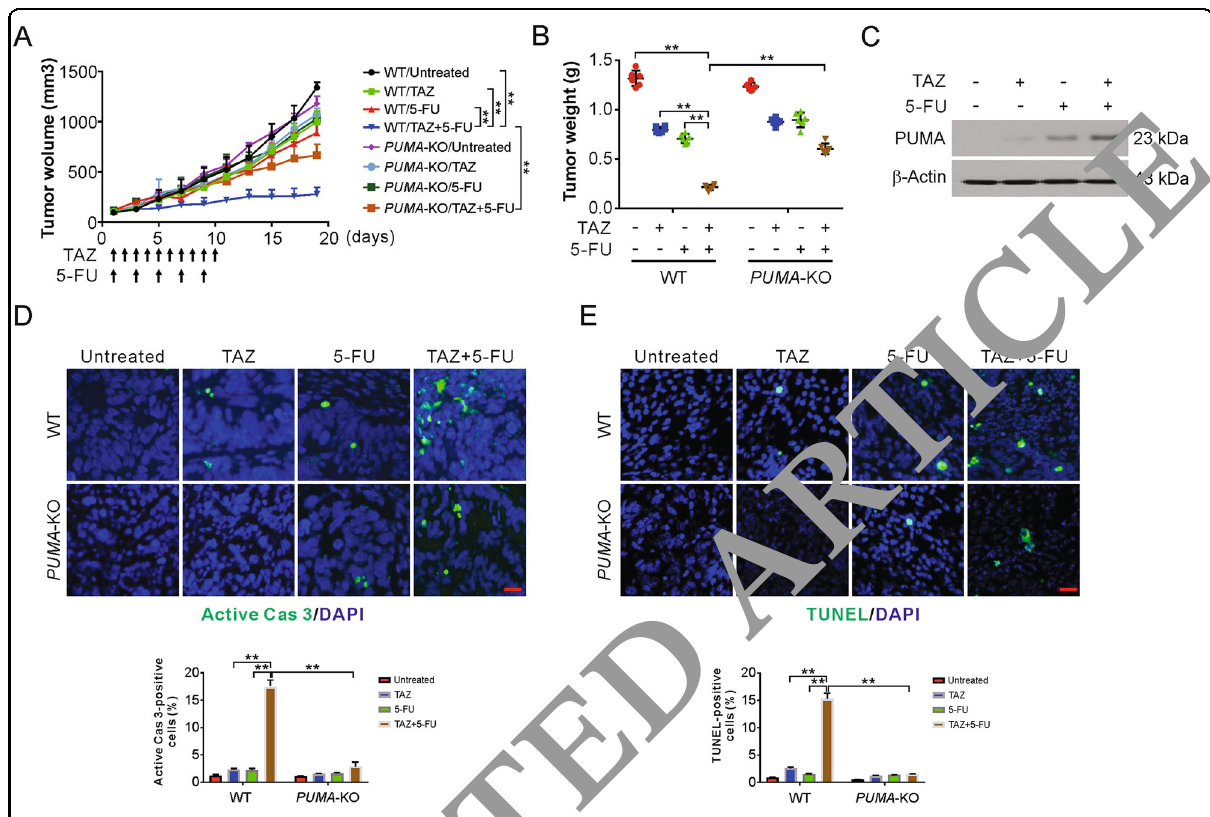
Fig. 6 The antitumor effects of regorafenib in vivo are PUMA-dependent. A Nude mice were injected s.c. with 5 × 10 5 WT or PUMA -KO HCT116 cells. After 1 week, mice were treated with tazemetostat, 5-FU, or their combination as indicated. Tumor volume at indicated time points after treatment was calculated and plotted with P values, n = 6 in each group. B At the end of the treatment, the mice were sacri fi ced and the tumors were removed and weighed. C Mice were treated with tazemetostat, 5-FU, or their combination as in ( A ) for 4 consecutive days. The PUMA expression in the indicated tumors were analyzed by western blotting. D Mice were treated with tazemetostat, 5-FU, or their combination as in ( A ) for 4 consecutive days. Paraf fi n-embedded sections of WT or PUMA -KO tumor tissues were analyzed by active caspase 3 staining. Active caspase 3-positive cells were counted and plotted. E Mice were treated with tazemetostat, 5-FU, or their combination as in ( A ) for 4 consecutive days. Paraf fi n- embedded sections of WT or PUMA -KO tumor tissues were analyzed by TUNEL staining. TUNEL-positive cells were counted and plotted. The results were expressed as the mean ± SD of three independent experiments. ** P <